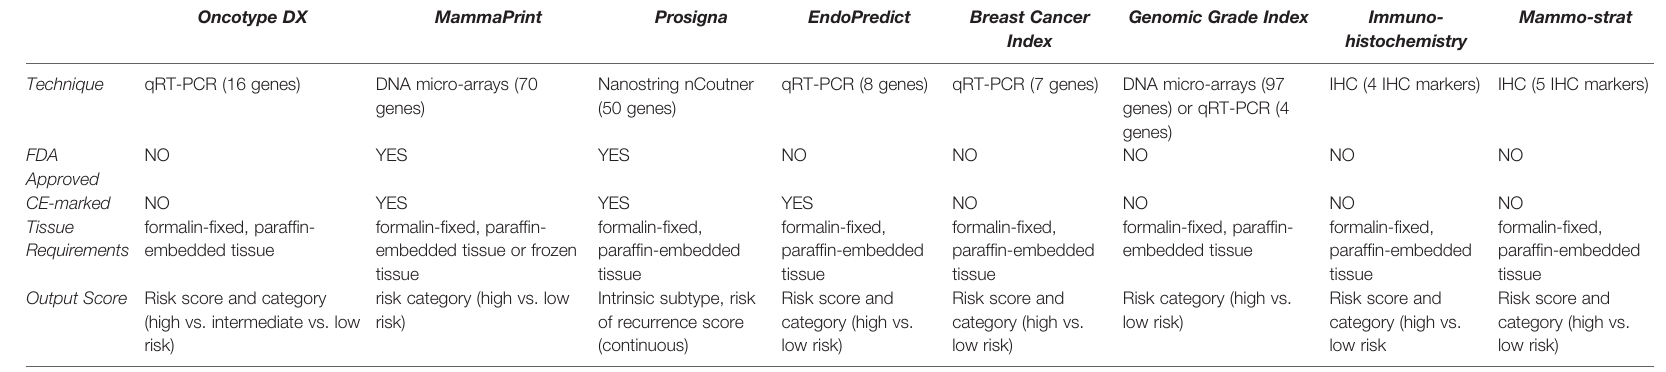
TABLE 1 | qRT-PCR, quantitative Reverse Transcriptase Polymerase Chain Reaction; CE, Conformite ́ Europe ́ enne.